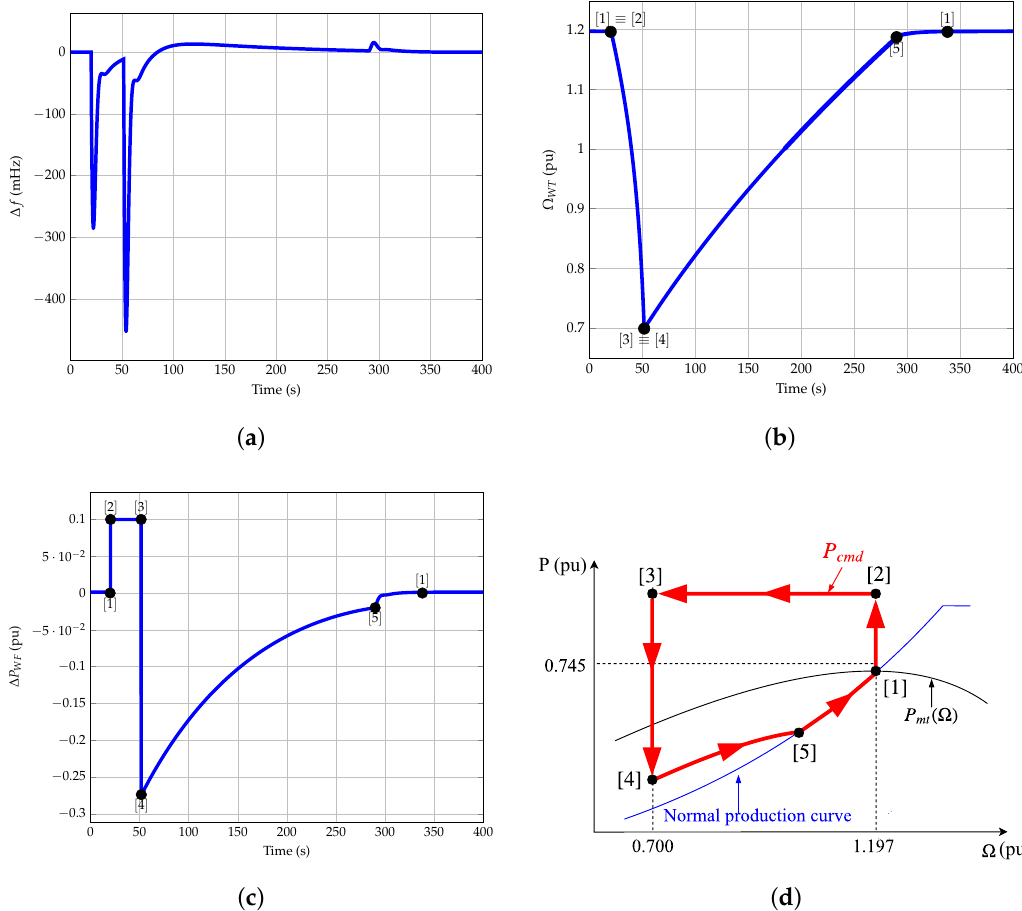
Figure 21. Wind power plant response for scenario 2 and frequency controller of [23]. ( a ) Frequency deviation; ( b ) Rotational speed; ( c ) Variation of wind power; ( d ) Frequency control strategy.